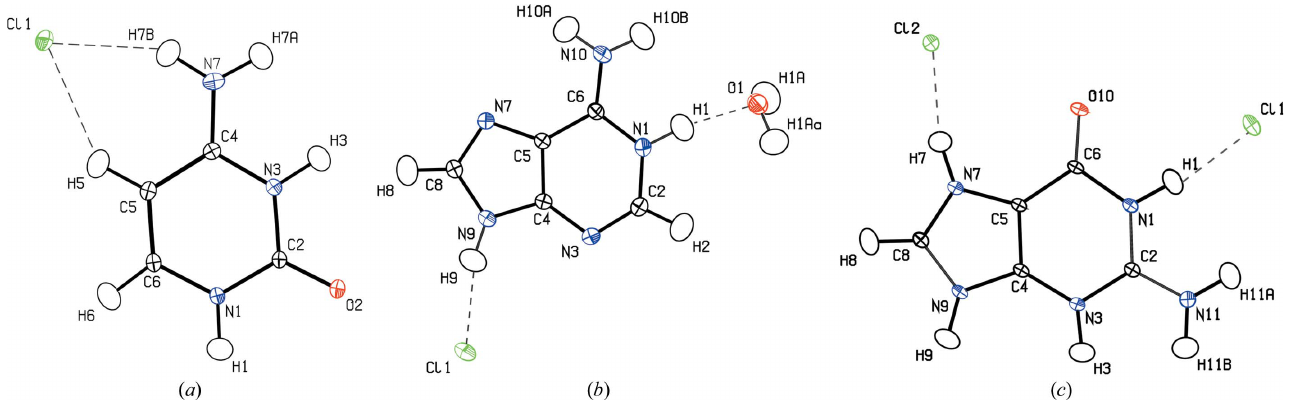
Figure 1 PLATON drawings, showing 50% probability ellipsoids, for the cytosinium chloride (CC), adeninium chloride hemihydrate (ACH) and guaninium dichloride (GDC)